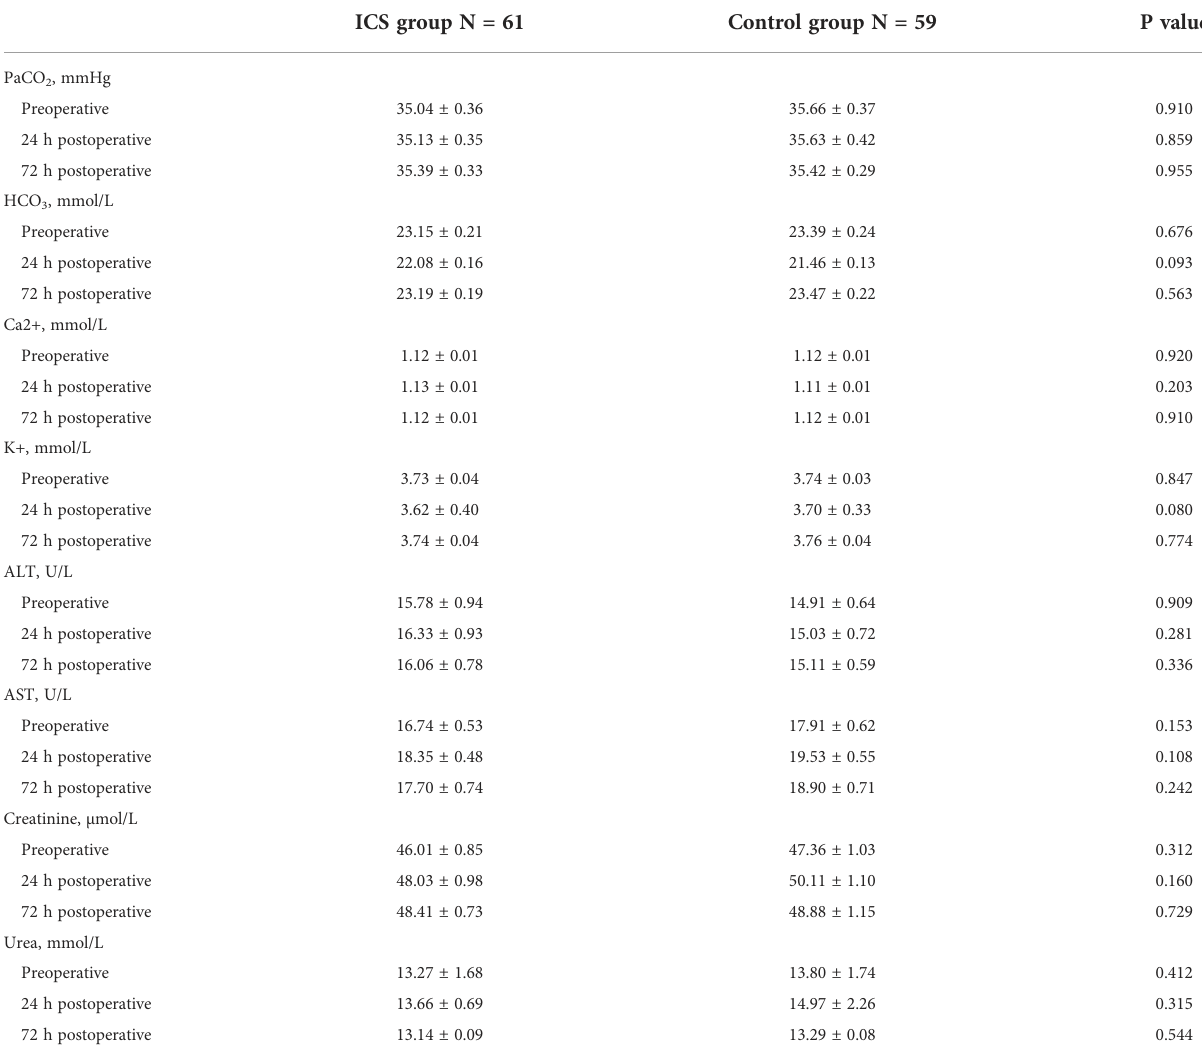
TABLE 3 Comparison of perioperative gas analysis, electrolytes, and liver and kidney function between the two groups. ICS group N =